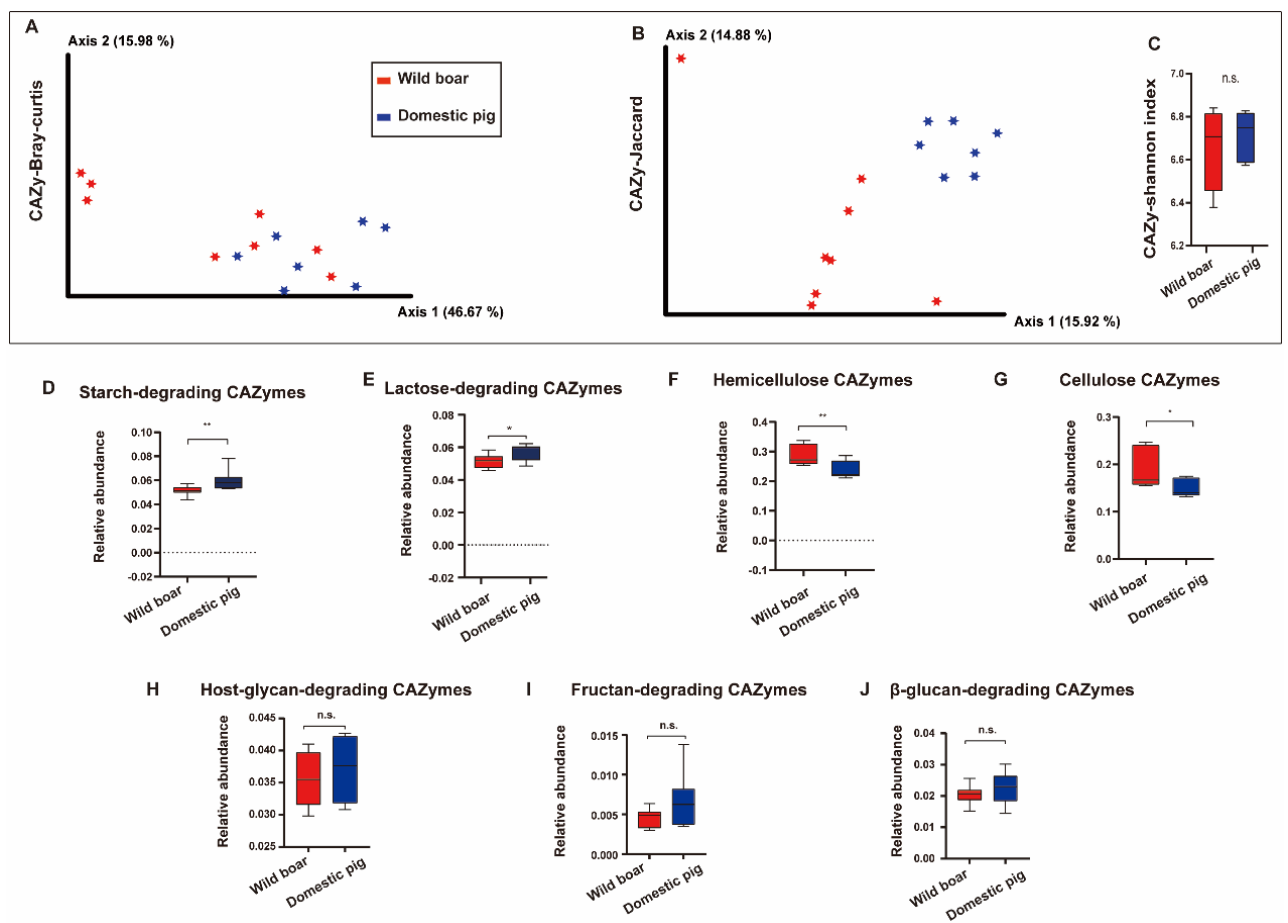
Figure 7. Diversity of CAZymes and the change of CAZymes between wild boar and domestic pig. ( A – C ): The CAZy of beta and alpha diversity. ( A ): Principal Coordinate Analysis (PCoA) of CAZymes based on Bray–Curtis distances. ( B ): Principal Coordinate Analysis (PCoA) of CAZymes based on Jaccard distances. ANOSIM, p < 0.05, red and blue circles represent bacterial communities in pigs in the wild boar and domestic pig groups, respectively. Alpha diversity is Shannon index (c), n.s., no significance, Mann–Whitney U-test. Red and blue bars represent wild boar and domestic pigs, respectively. Different CAZymes of wild boar between domestic pigs. ( D ): Starch-degrading CAZymes, ( E ): Lactose ‐ degrading CAZymes, ( F ): Hemicellulose CAZymes, ( G ): Cellulose CA ‐ Zymes, ( H ): Host ‐ glycan ‐ degrading CAZymes, ( I ): Fructan ‐ degrading CAZymes, ( J ): β‐ glucan ‐ de ‐ grading CAZymes. Whitney U ‐ test, * p <0.05, ** p <0.01, *** p < 0.001, **** p < 0.0001. The red bars and blue bars represent wild boar and domestic pigs, respectively. Boxplot indicates the interquartile range (IQR). The line in the box represents the middle value, and the error bars represent the lowest and highest values,